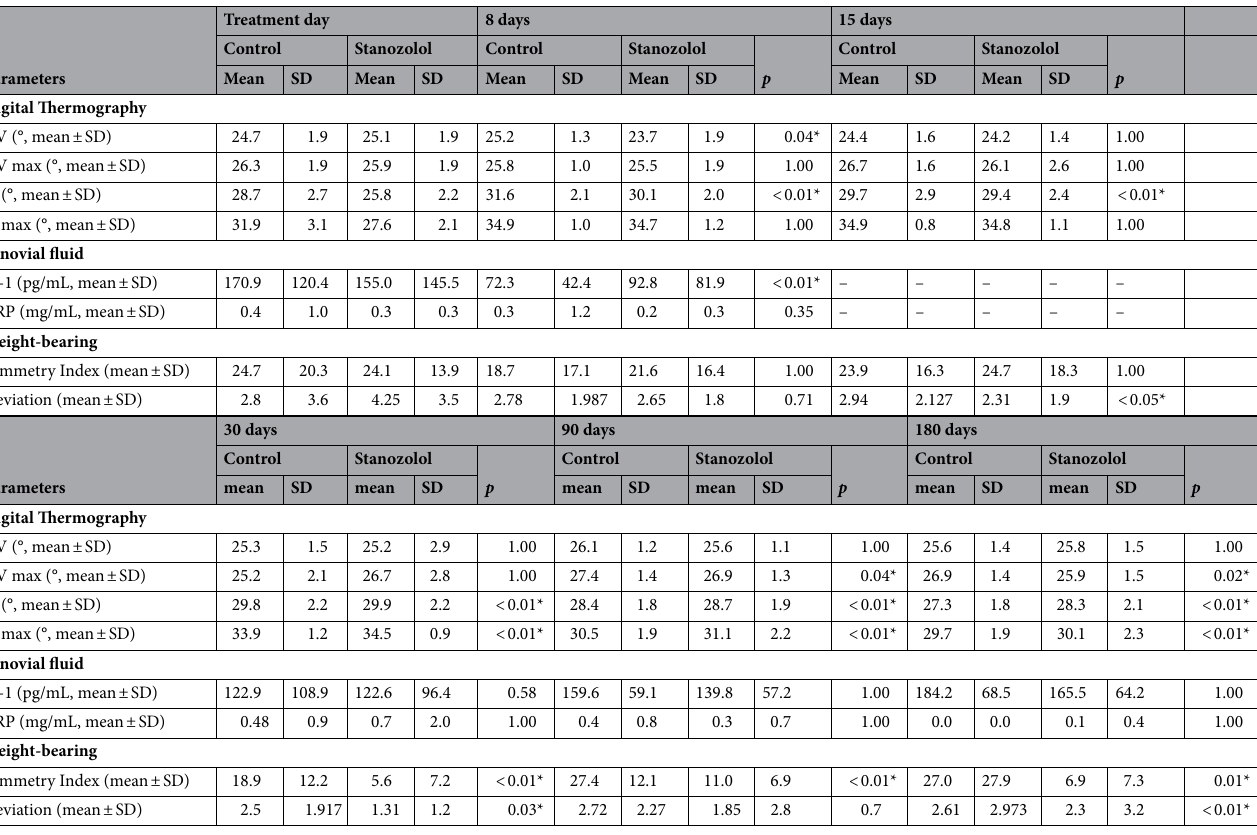
Table 2. Mean values (± standard deviation) of digital thermography, weight-bearing and synovial IL-1 and CRP evaluated throughout the study. CRP C-reactive protein, DV dorsoventral view, IL-1 Interleukin 1, LT lateral view. P values for the comparison of both groups at each follow-up moment are presented. *Indicates